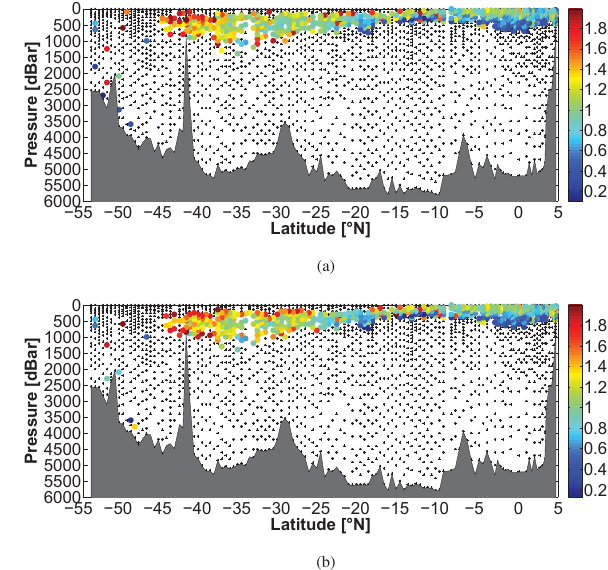
Figure 12. Constrained (cid:49)/(cid:48) ratios of the CLIVAR A13.5 section Fig. 12: Constrained Δ / Γ ratios of the CLIVAR A13.5 section along the Greenwich Meridian in 2010 using the tracer couples along the Greenwich Meridian in 2010 using the tracer couples ( a ) CFC-12/SF 6 and ( b ) CFC-11/SF 6 . The black dots indicate data below the detection limit and data outside the application (a) CFC-12/SF 6 and (b) CFC-11/SF 6 . The black dots indicate data range of the IG-TTD. below the detection limit and data outside the application range of the IG-TTD.